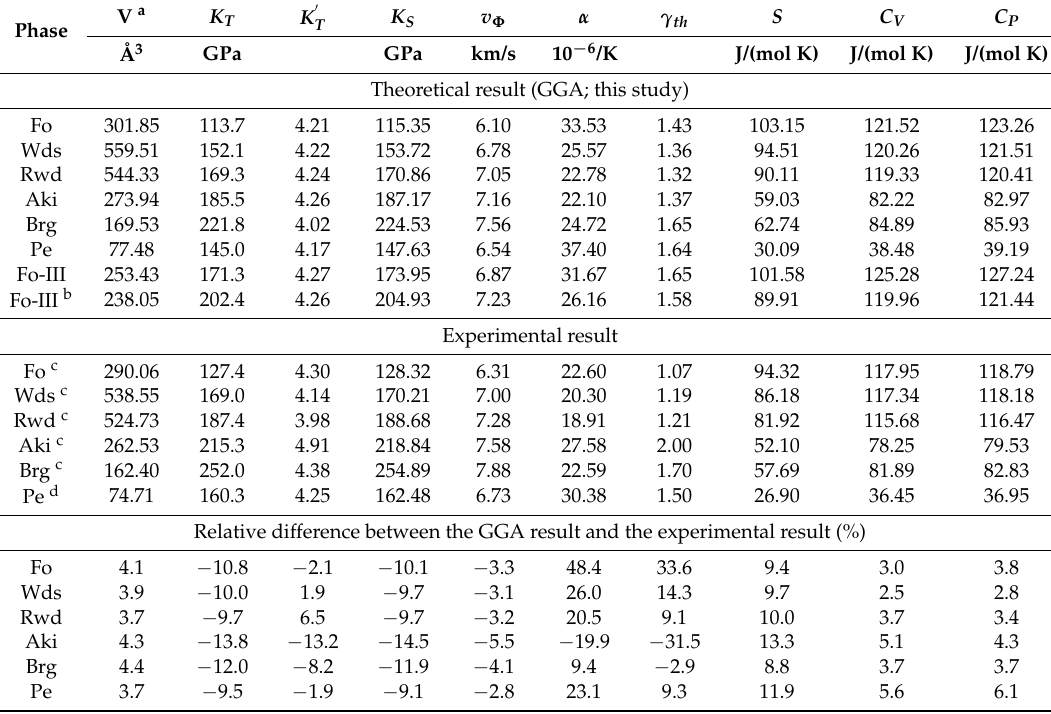
Table 6. Calculated and/or experimental thermodynamic properties for Fo, Wds, Rwd, Aki, Brg, Pe and Fo-III at 1 atm and 300